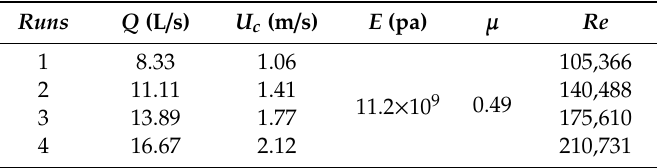
Table 1. Parameter